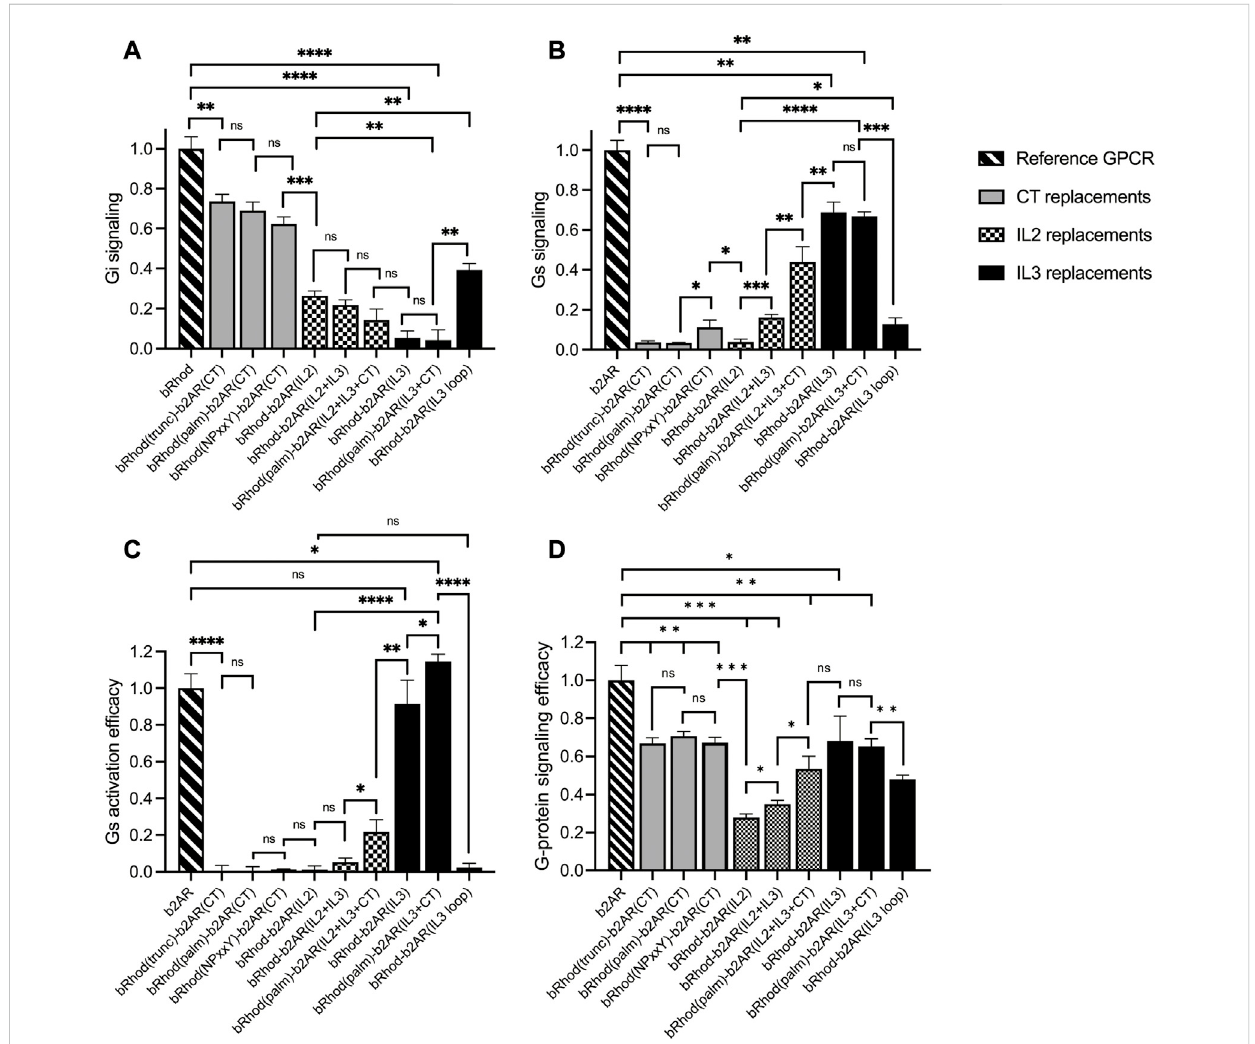
FIGURE 2 Shift from Gi to Gs activation of bRhod-b2AR chimeras determined with the GloSensor second messenger assay. (A,B) Normalized cAMP decrease indicative of Gi activation (A) and normalized increase indicative of Gs activation (B) . The reporter luminescence values of the chimeras were normalized to WT bRhod (A) and WT b2AR (B) values, respectively (N = 9). IL3 replacements, without and with the C-terminus additionally replaced at the palmitoylation site shifted bRhod-b2AR chimera signalling clearly to Gs. (C) Gs activation ef fi cacy was calculated by dividing max. Gs value by the max. Gi value for each opsin variant. WT b2AR was normalized to 1, all other variants were normalized to WT b2AR (N = 3). bRhod-b2AR(IL3) activated Gs asef fi cientlyas WTb2AR,bRhod(palm)-b2AR(IL3+CT) signi fi cantly exceededWT b2ARactivity. (D) OverallG-protein signaling ef fi cacywascalculated by dividing the sum of Gi and Gs activation by 2. Light stimulus: 5 × 10 16 photons/cm 2 /s. Raw data traces can be found in Supplementary Figure